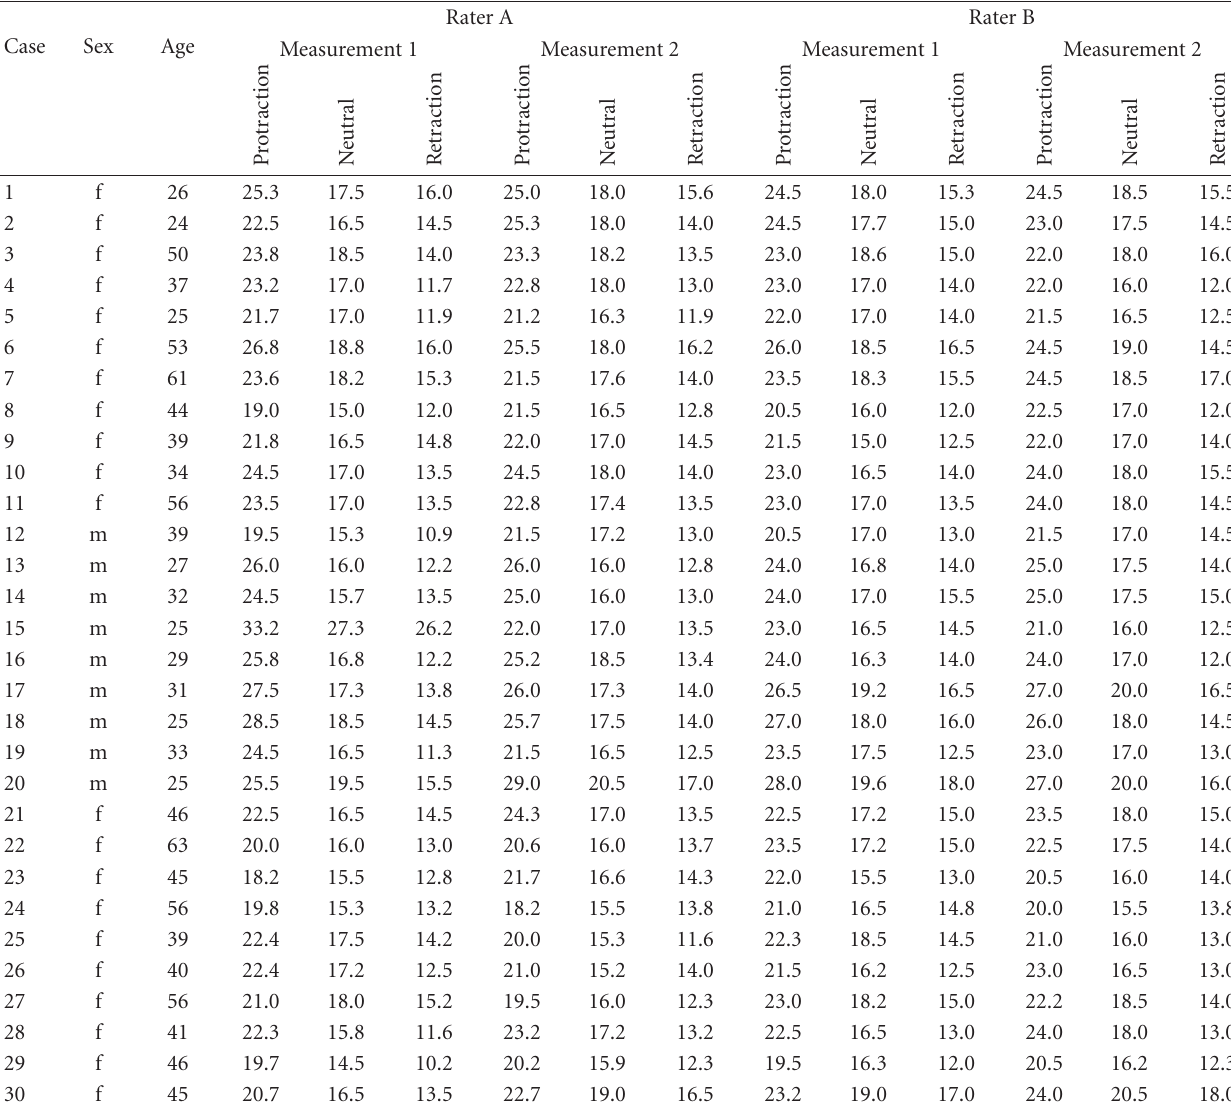
Table 1: Horizontal distance (cm) between the reference plane (the wall) and the measuring point (the Myrin inclinometer needle) during maximum active protraction, neutral position, and maximum active retraction for the two raters and the two measurements.